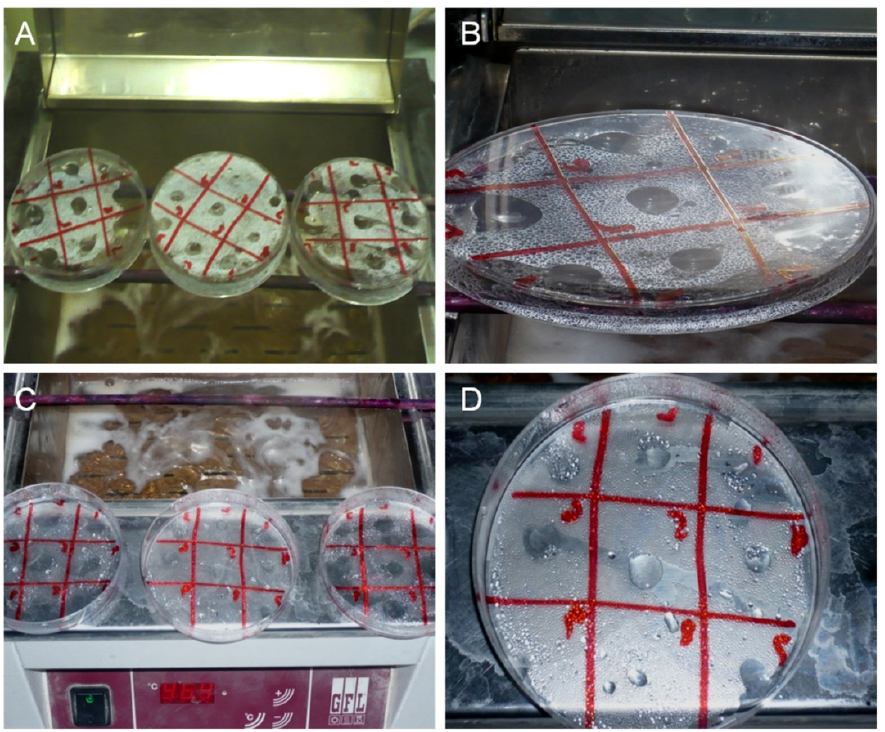
Figure 1. Thin layer immunoassay steps to detect the antibody titer. ( A ) Incubation of polystyrene plate along with different dilutions of patient’s serum over water bath. ( B ) Plate containing droplets after 1 min incubation over bath. ( C ) Water droplets after rinsing with distilled water, blow dried, and again inverted over the water bath at 60 °C. ( D ) Plates showing water droplets regarded as positive results for H. pylori .